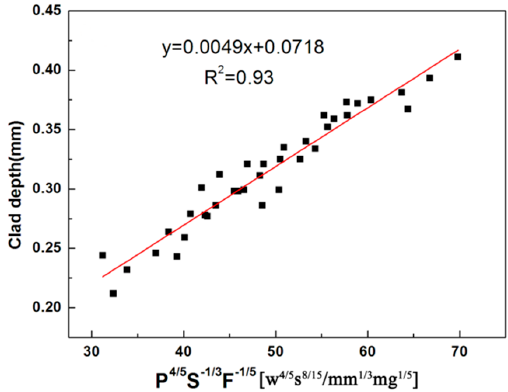
Figure 6. Relationship between the clad depth and P 4/5 S − 1/3 F − 1/5 .